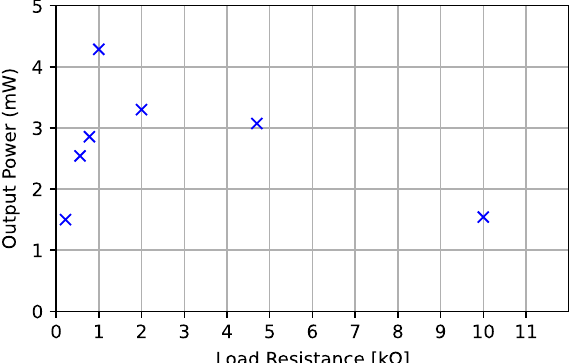
Figure 9. Output power generated by a half spin of the MGS 32.8, as a function of load